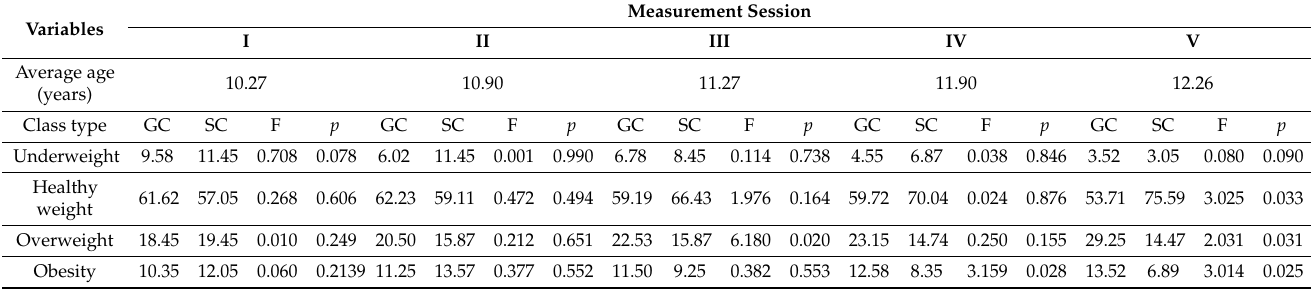
Table 3. The percentage of fat mass categories in the GC and SC girls during the course of the